Question: What form of chart is displayed?
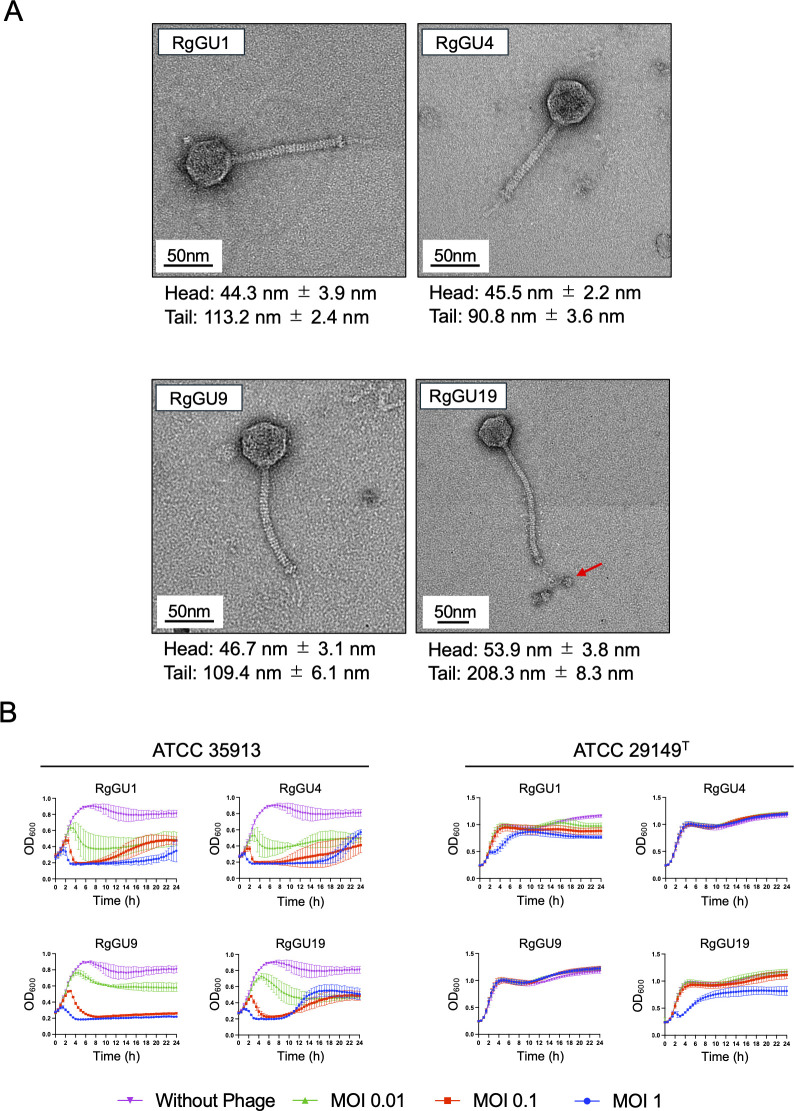
Answer: bar